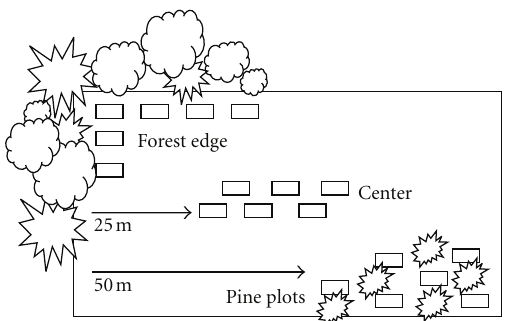
Figure 1: Schematic diagram of field plot layout representing one block (0.80ha). In each block, three distinct areas were designated as habitat types: forest edge (near the edges), center (away from edges), and in the vicinity of established plantings of 10-year-old Pinus virginiana (pine plots). Six plots (4m × 3m) were established in each habitat type, each containing 20 chestnut seeds. There were a total of three blocks, each block comprised of 18 plots. In total, there were 54 plots containing a total of 1080